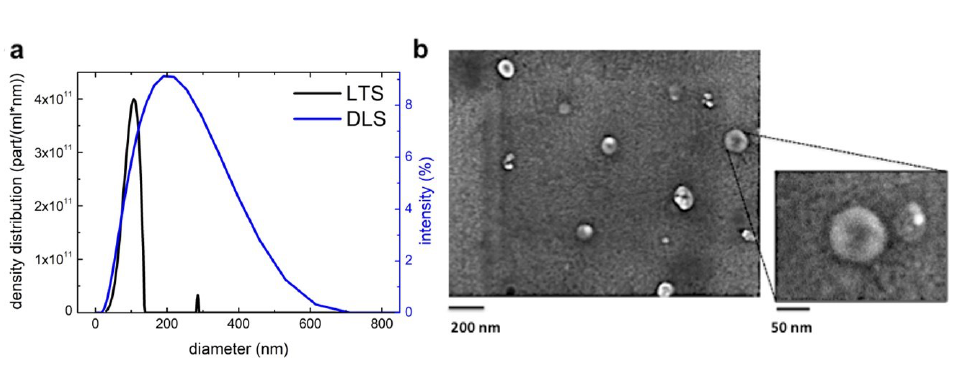
Figure 1. Characterization of blueberry-derived exosome-like nanoparticles (B-ELNs) ( a ) size distribution was determined by laser transmission spectroscopy (LTS) and dynamic light scattering (DLS) analysis. The black line shows results obtained with LTS apparatus and the blue line with DLS apparatus ( b ) morphology of B-ELNs was analyzed under scanning electron microscopy (SEM). The large-field was obtained at 70 × magnification (scale bar 200 nm); the insert at 150 × (scale bar 50